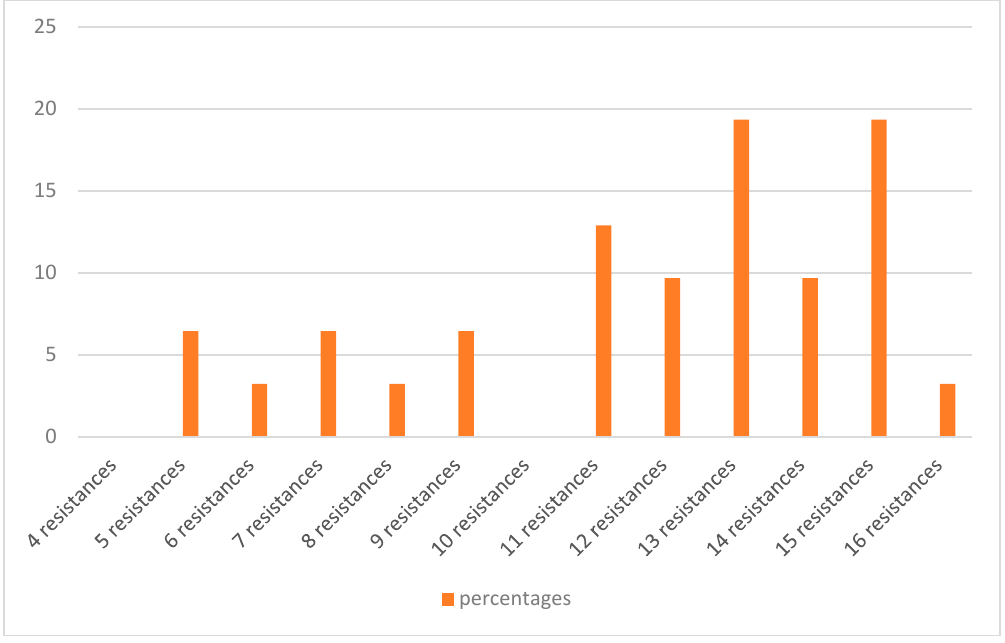
Figure 1. The percentages of MDR E. coli resistant to different numbers of antibiotics .